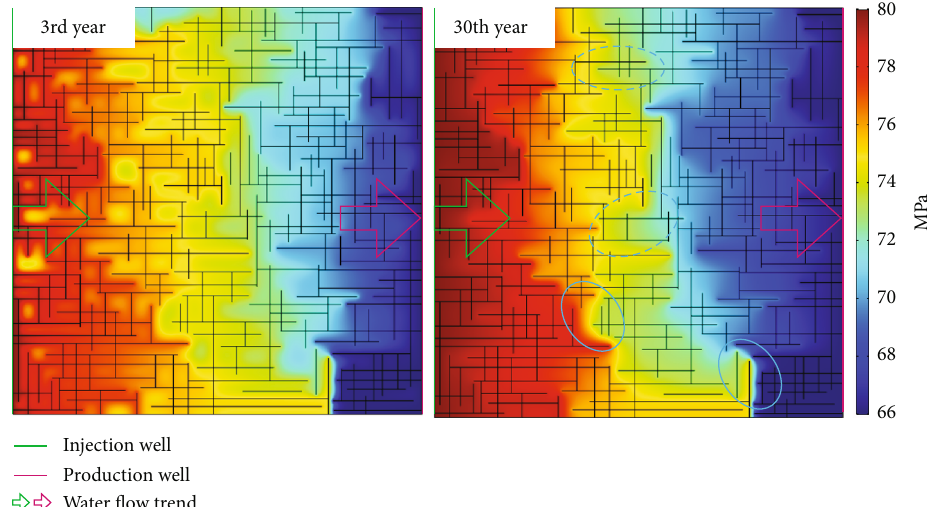
Figure 7: Pressure distribution of the reservoir at the 3rd year and 30th year.